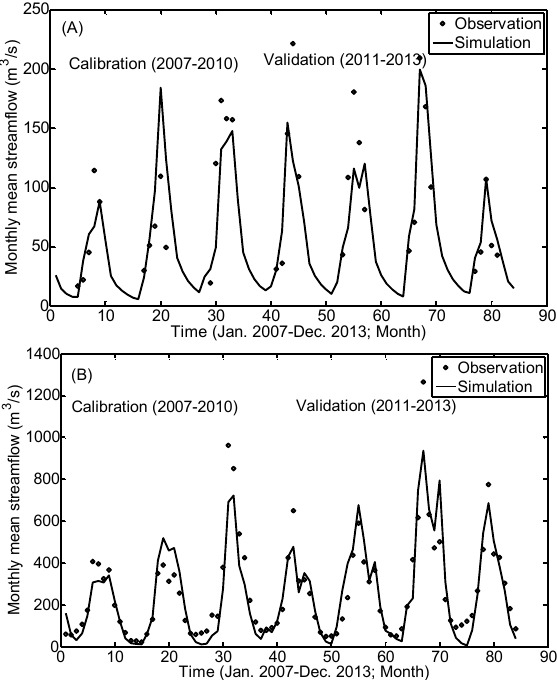
Figure 3. HBV model simulated and observed average monthly streamflow within designated calibration (2007–2010) and validation (2011–2013) periods at the outlet of the ( A ) Tuotuo River Basin and the ( B ) Ganzi Basin.